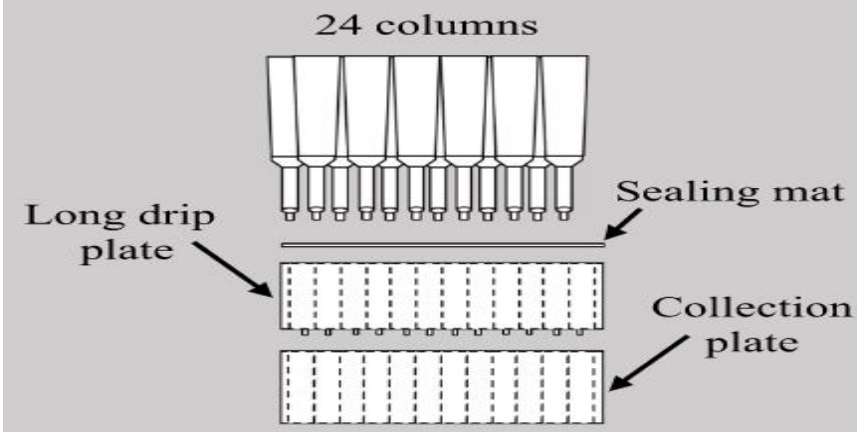
Figure 1. Schematic assembly of the MCPA system [9].